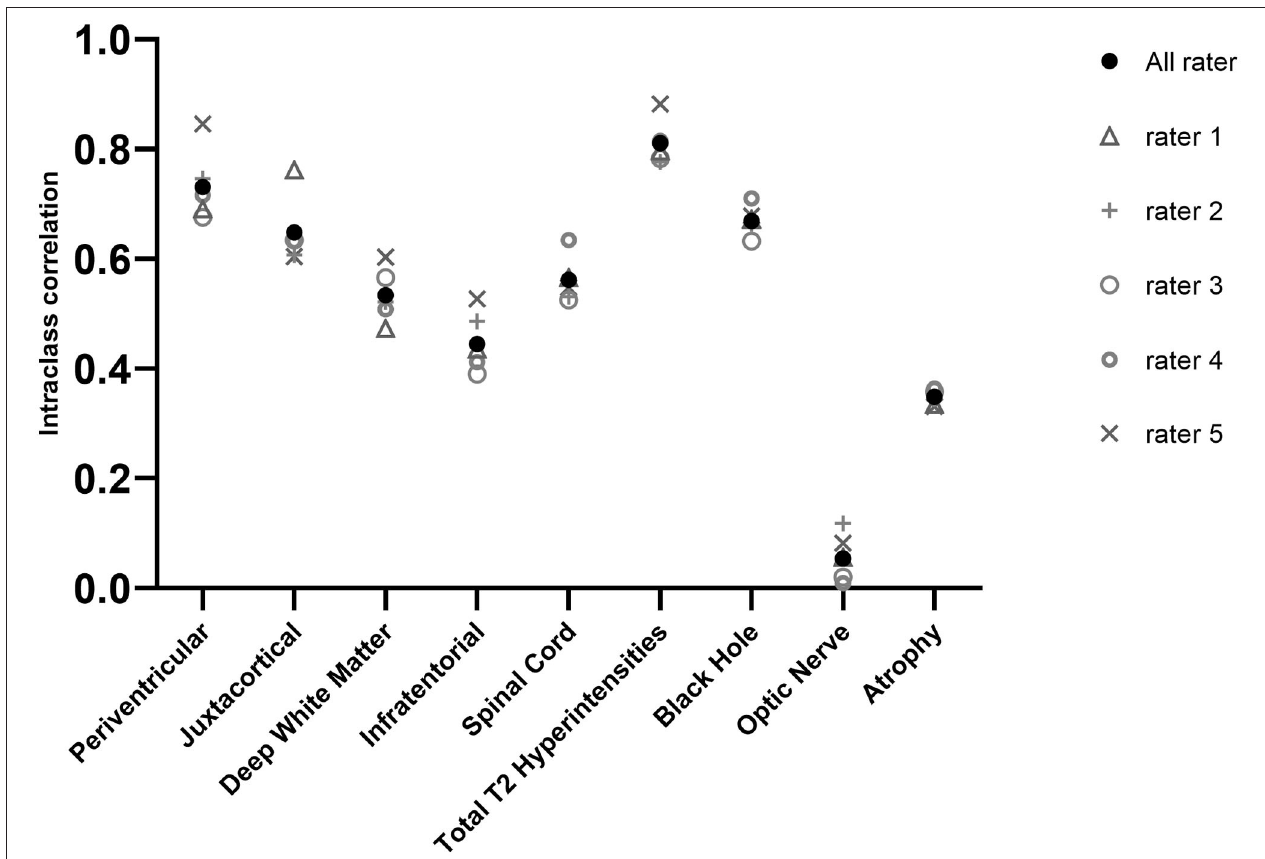
FIGURE 5 | ICCs for all raters and when we left out different ones. For example, rater 1 shows ICC for the other 4 thus a higher value means lower performance for the